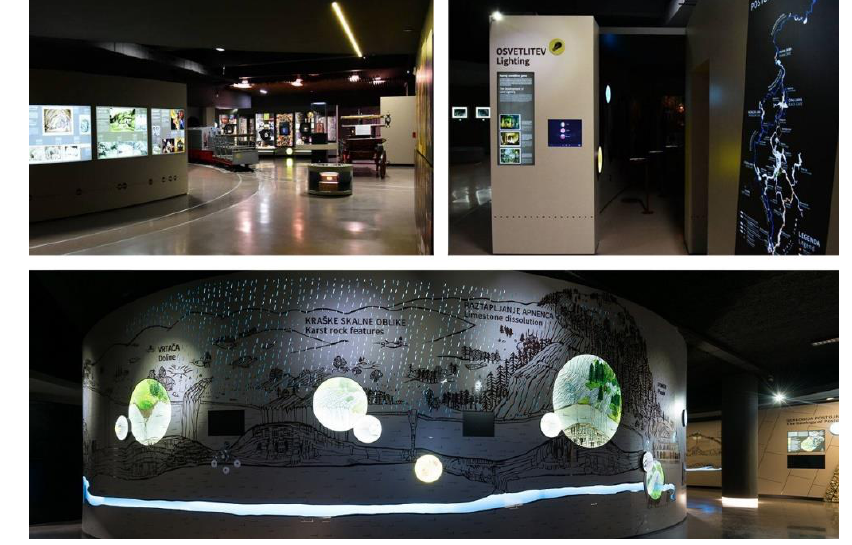
Figure 10. Expo Museum.